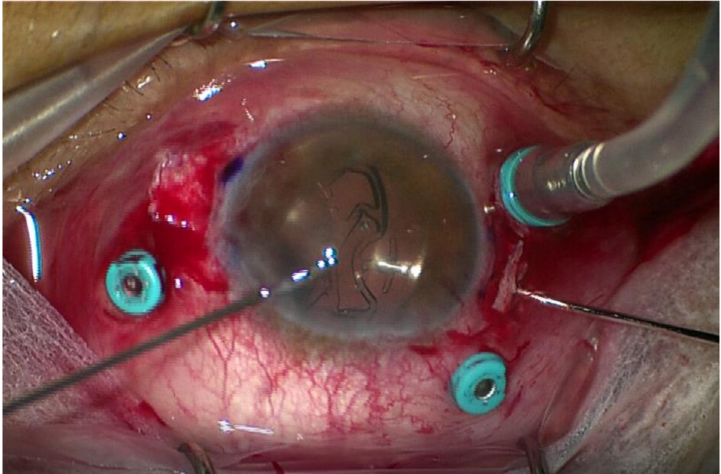
Figure 2. Carlevale lens fixation: the 25-gauge forceps are passed through the side anterior chamber incision to maintain the second haptic of the IOL and to gently move it under the iris, so that the sec- ond plug is gripped by another pair of 25-gauge forceps and passed through the opposite sclerotomy. The sealing of scleral flaps and the conjunctival wound with polyglactin 8–0 Vicryl suture and the closure of the corneal incision with hydrosuture was